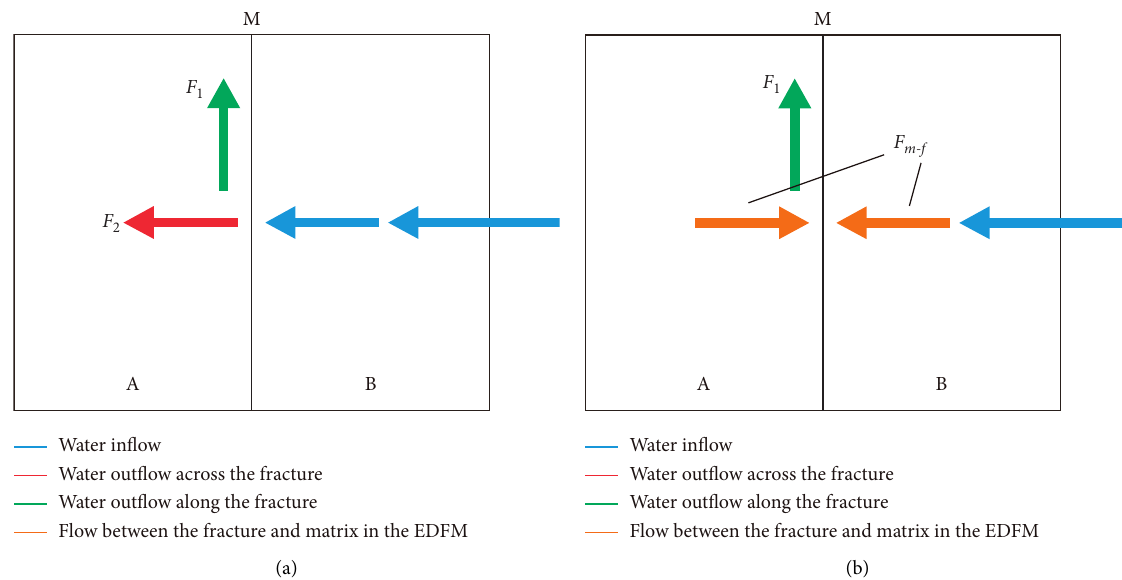
Figure 1: Flow process for water displacement across a fracture in (a) realistic scenario and (b) EDFM.